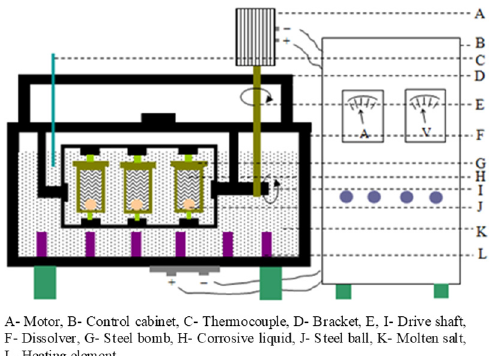
Figure 1. Schematic diagram of the autoclave for the immersion corrosion experiment.